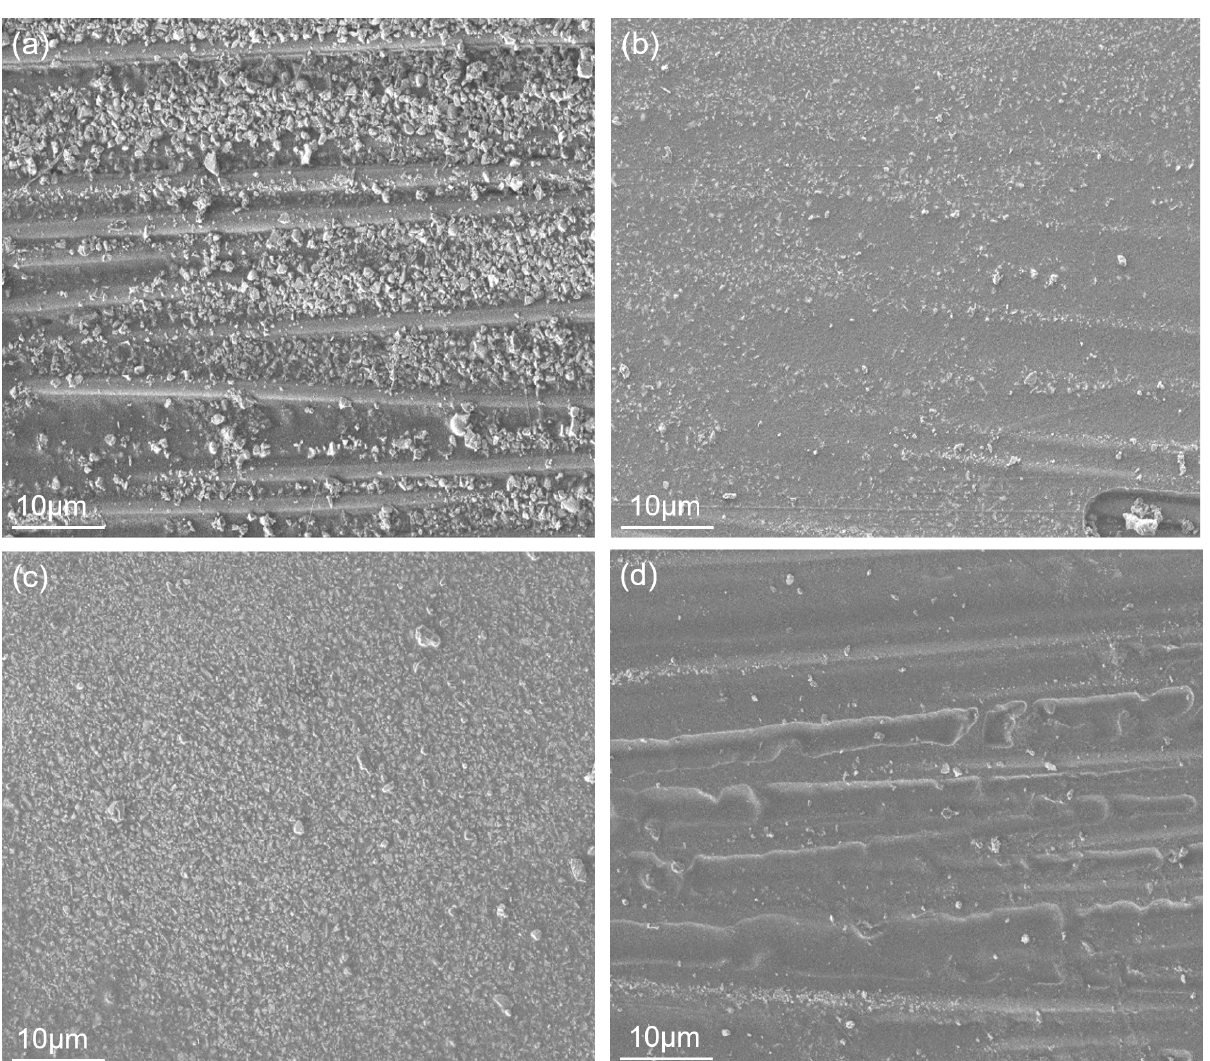
Figure 7: SEM images of composites with 4% nano-silica: sequence I: (a) resin surface (b) fiber surface and resin film; sequence II: (c) resin surface, (d) fiber